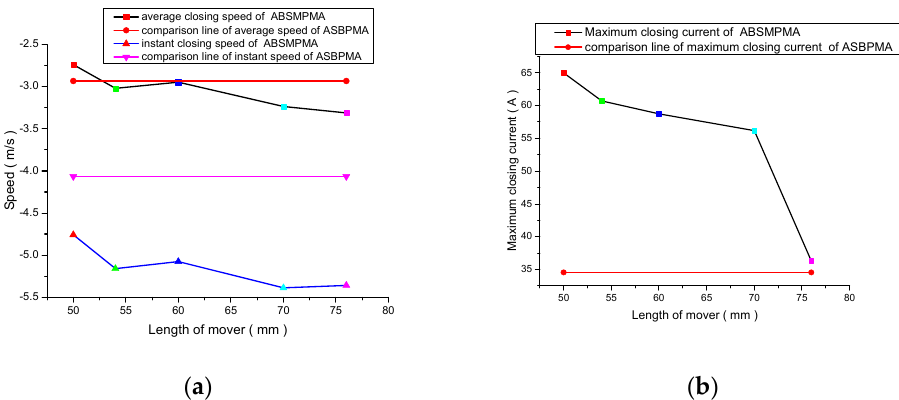
Figure 8. The closing characteristics are shown. ( a ) The characteristics of the length of mover vs. closing speed. ( b ) The characteristics of the length of mover vs. maximum closing current.